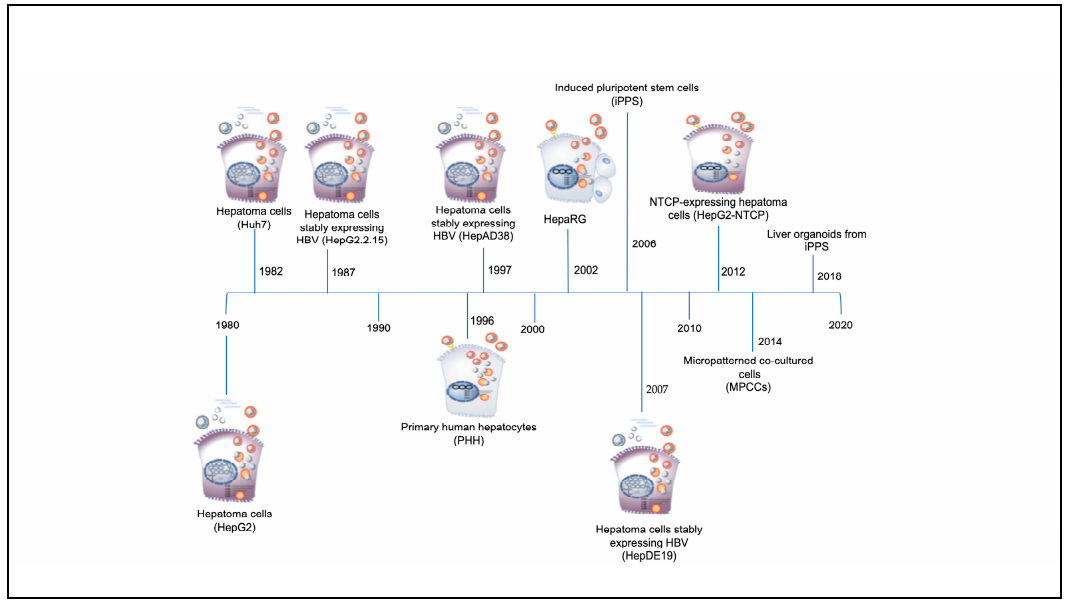
Figure 2. Timeline of discovery of in vitro hepatitis B virus (HBV) systems (adapted from [45]).